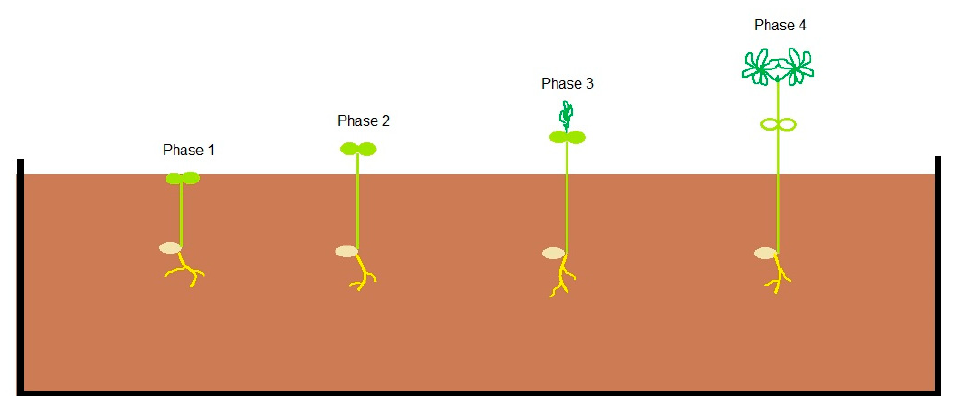
Figure 1. General plant phases used during the artificial simulated frost tolerance tests on the L. albus commercial cultivar Mihai and L. mutabilis accessions LIB 220, LIB 221, and LIB 222.